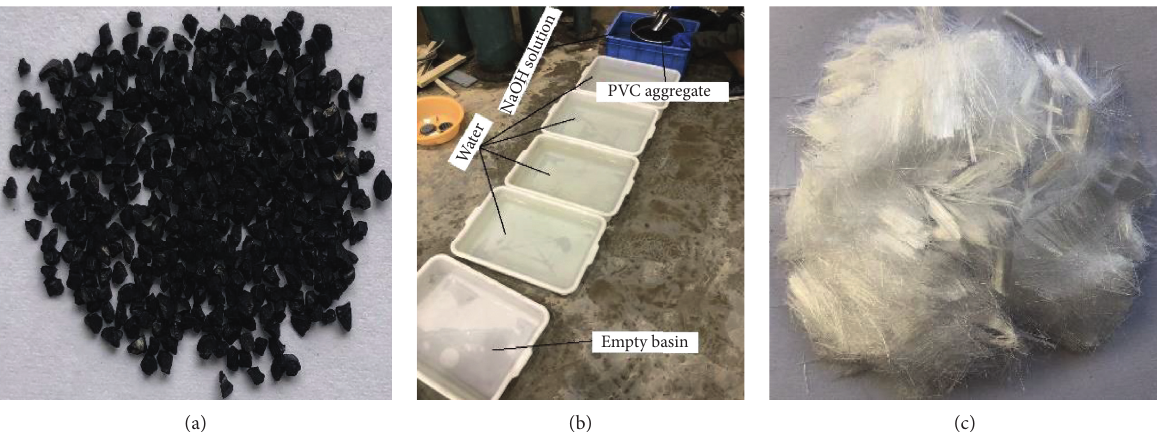
Figure 1: Modification process of PVC aggregate and polypropylene fiber used in test. (a) PVC aggregate. (b) Modified treatment process. (c) Polypropylene fiber.